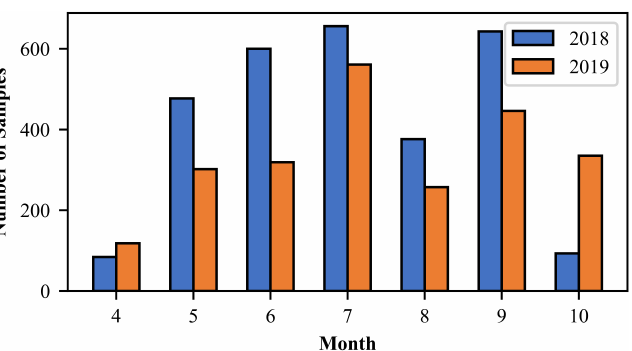
Figure 2. Number of samples for model training and validation in each month of 2018–2019.